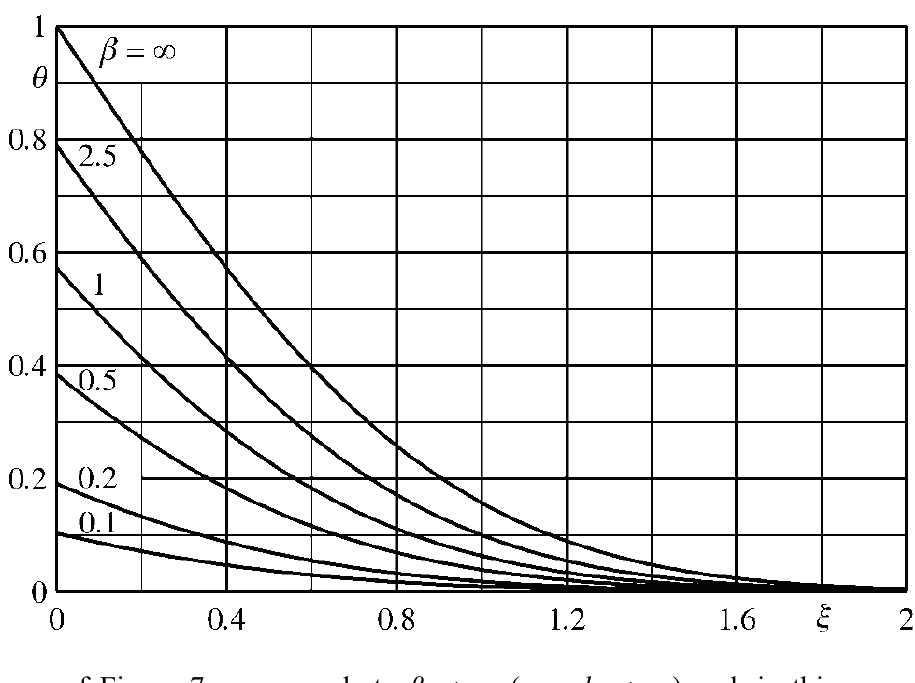
Figure 7. Dimensionless temperature profiles, for several β values, in a semi-infinite wall at a constant initial temperature and subjected to a constant h and T r . Adapted from